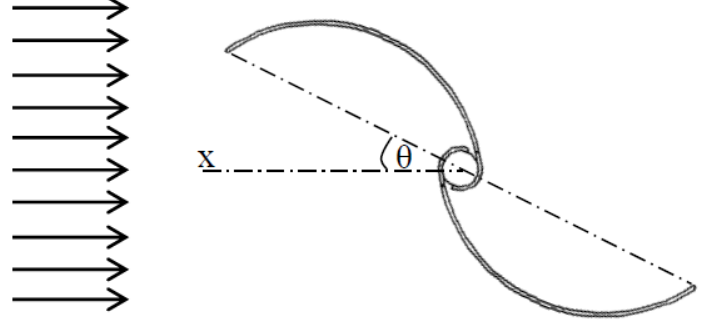
Figure 8. A position angle θ of the turbine’s two blades.